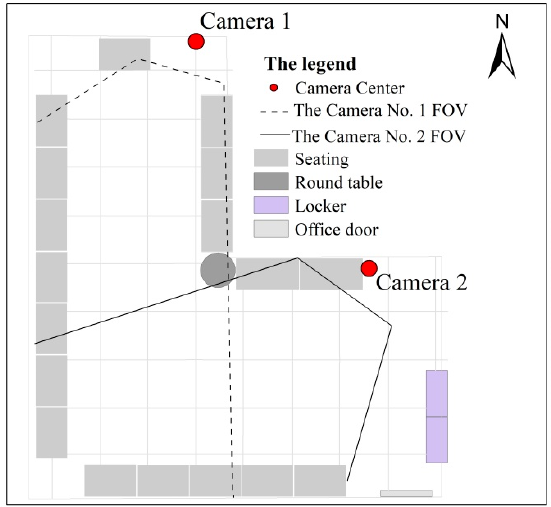
Figure 7. The 2D map of an office.